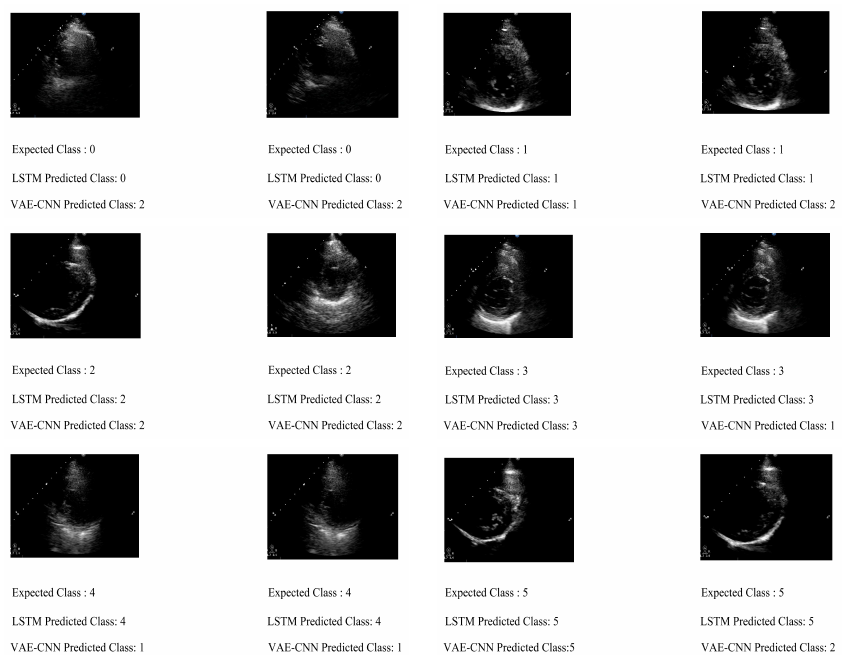
Figure 20. Output of expected and predicted class for six-class classification using generaliza- tion